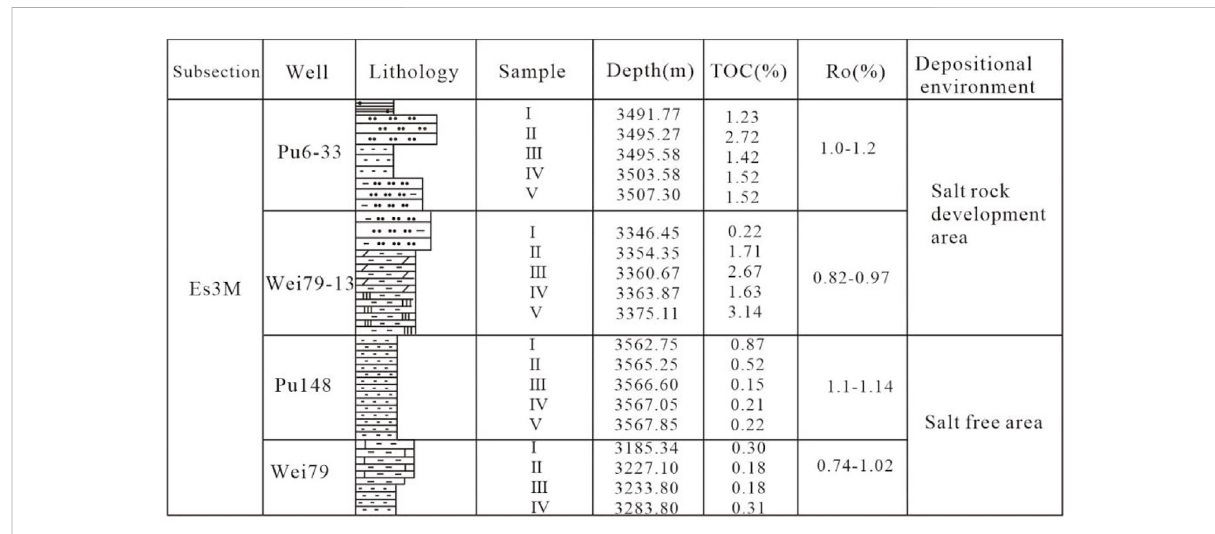
FIGURE 4 Geochemical characteristics of shales with different sedimentary environments in the northern Dongpu Depression.